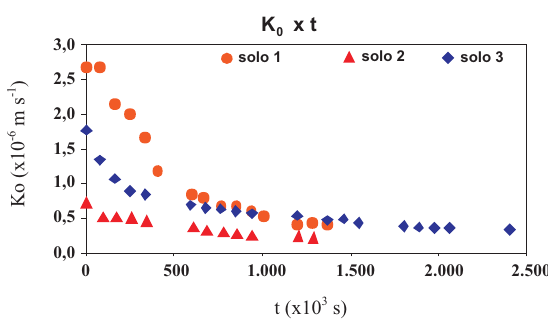
Figura 2. Condutividade hidráulica saturada em função do tempo (solo 2), média das repetições e respectivos desvios-padrão (barras verticais).